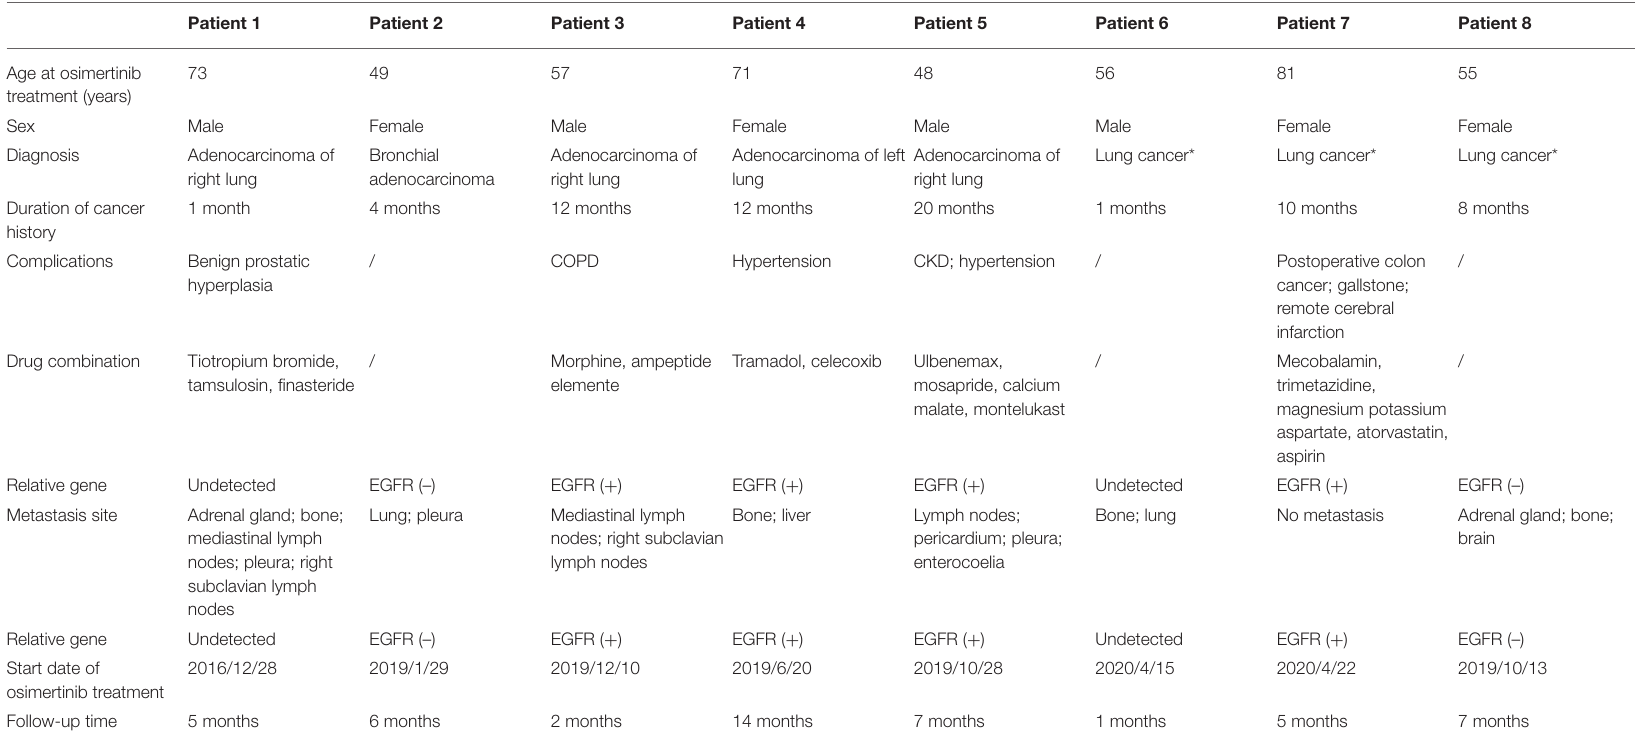
TABLE 3 | Clinical characteristics of patients who received osimertinib at the 3rd Xiangya